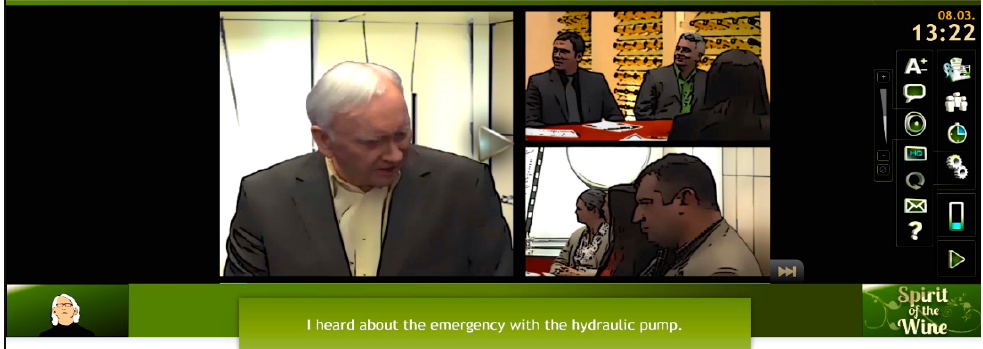
Figure 2. FLIGBY interface (authors’ own illustration).